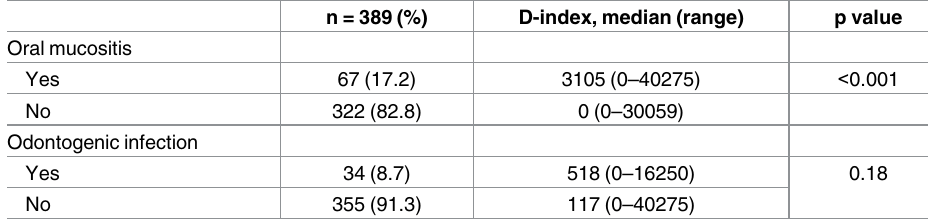
Table 2. Relationship between D-index and oral